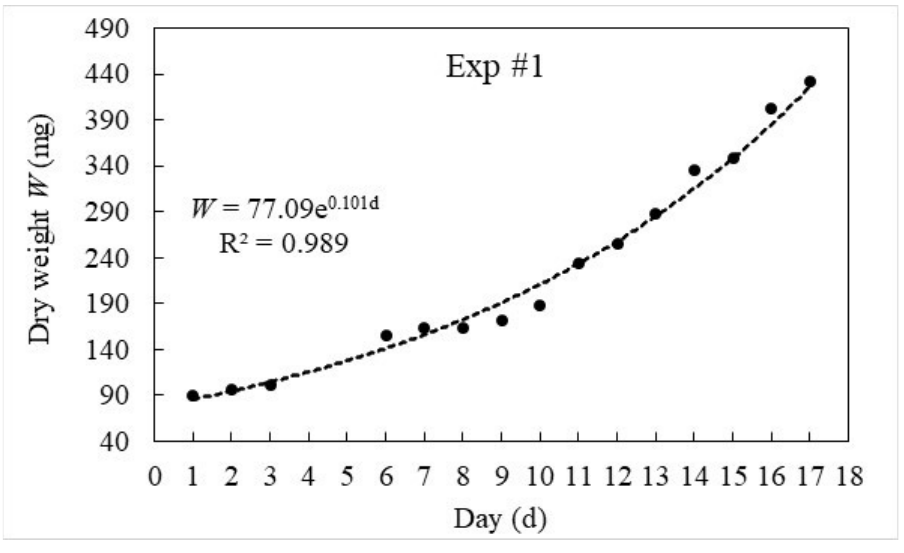
Figure 1. Aurelia aurita . Increase in dry weight of jellyfish fed 25 Artemia l − 1 . The b -exponent of the exponential regression equations shows that the mean weight-specific growth rate is 10.1% d − 1 .